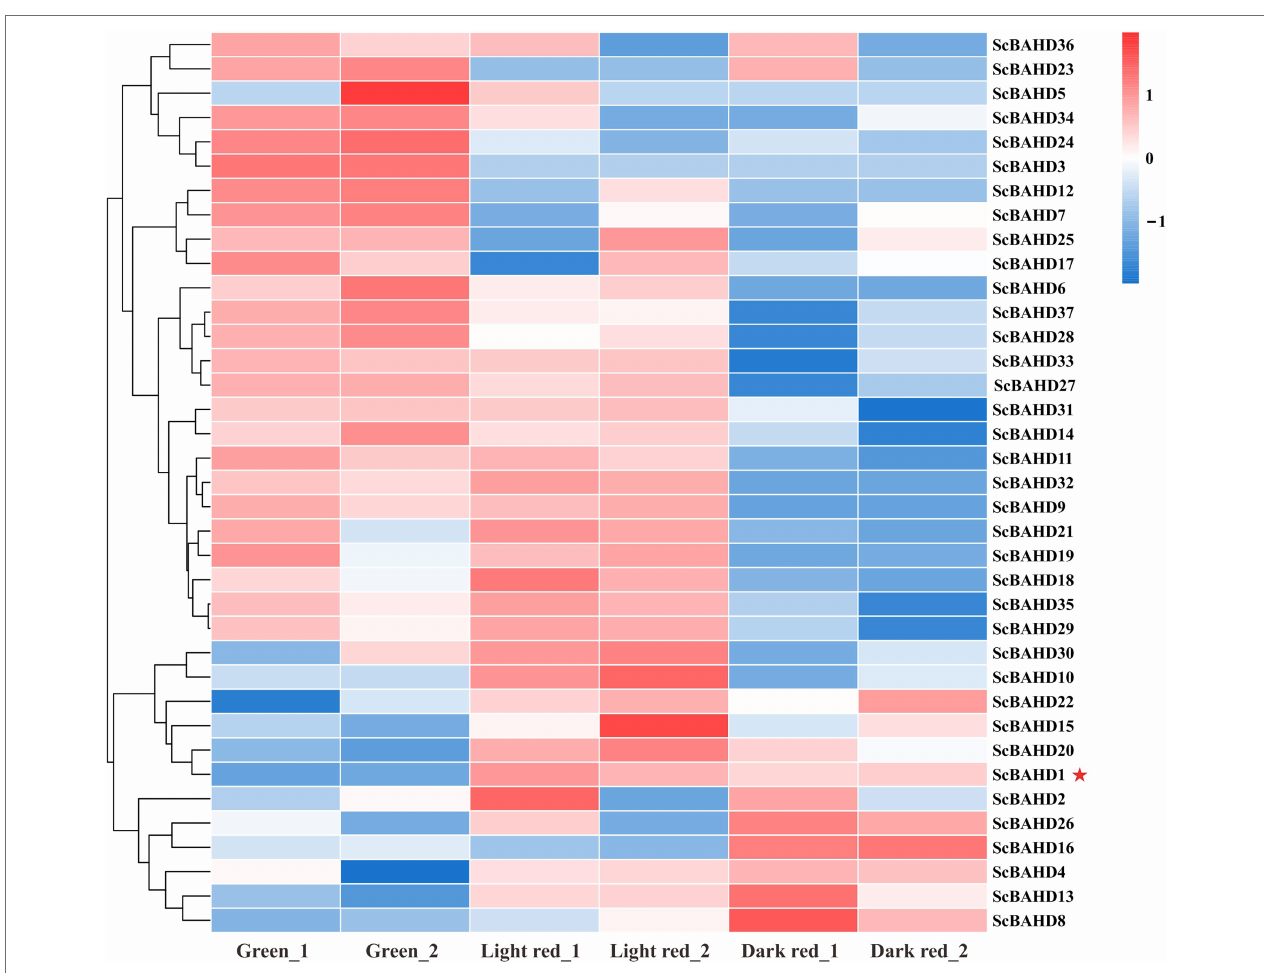
FIGURE 4 | Heat map exhibits expression patterns of 37 ScBAHD genes during the ripening stages of S. chinensis fruits, including the green stage (Green_1 and Geen_2), light red stage (Light red_1 and Light red_2), and dark red stage (Dark red_1 and Dark red_2). Red indicates high relative gene expression, whereas blue indicates low relative gene